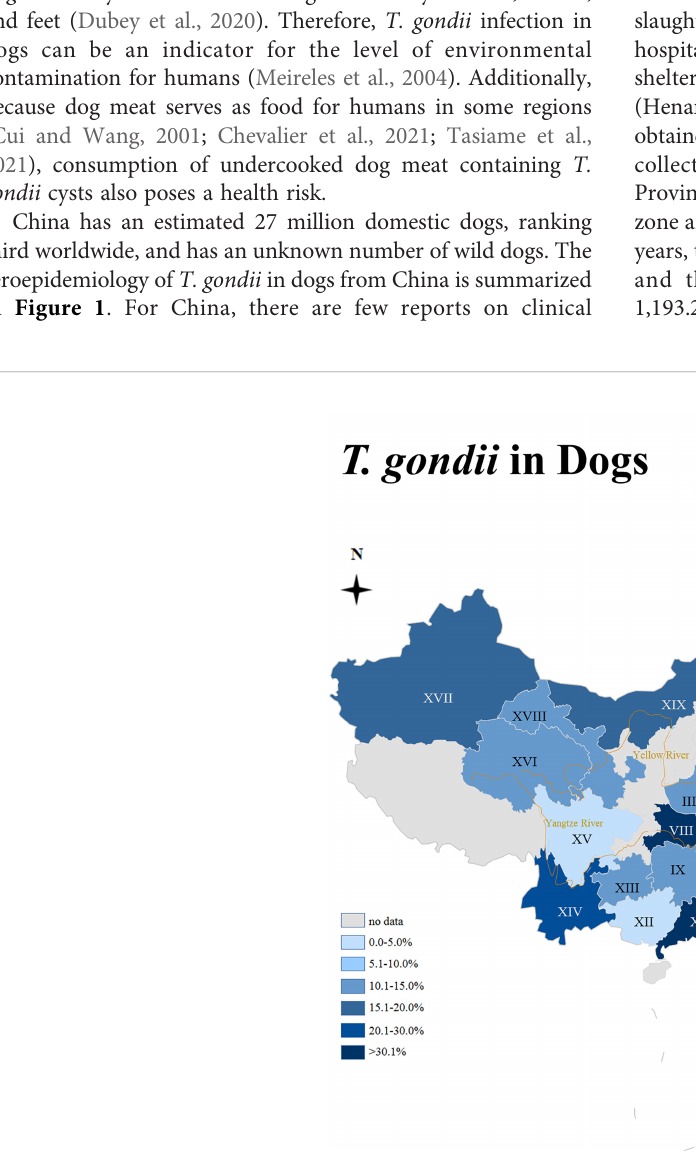
FIGURE 1 | Seroepidemiology of Toxoplasma gondii in dogs from China (2009 – 2021). I: Beijing, II: Shandong, III: Henan, IV: Anhui, V: Shanghai, VI: Jiangsu, VII: Zhejiang, VIII: Hubei, IX: Hunan, X: Fujian, XI: Guangdong, XII: Guangxi, XIII: Guizhou, XIV: Yunnan, XV: Sichuan, XVI: Qinghai, XVII: Xinjiang, XVIII: Gansu, XIX: Inner Mongolia, XX: Heilongjiang, XXI: Jilin, XXII: